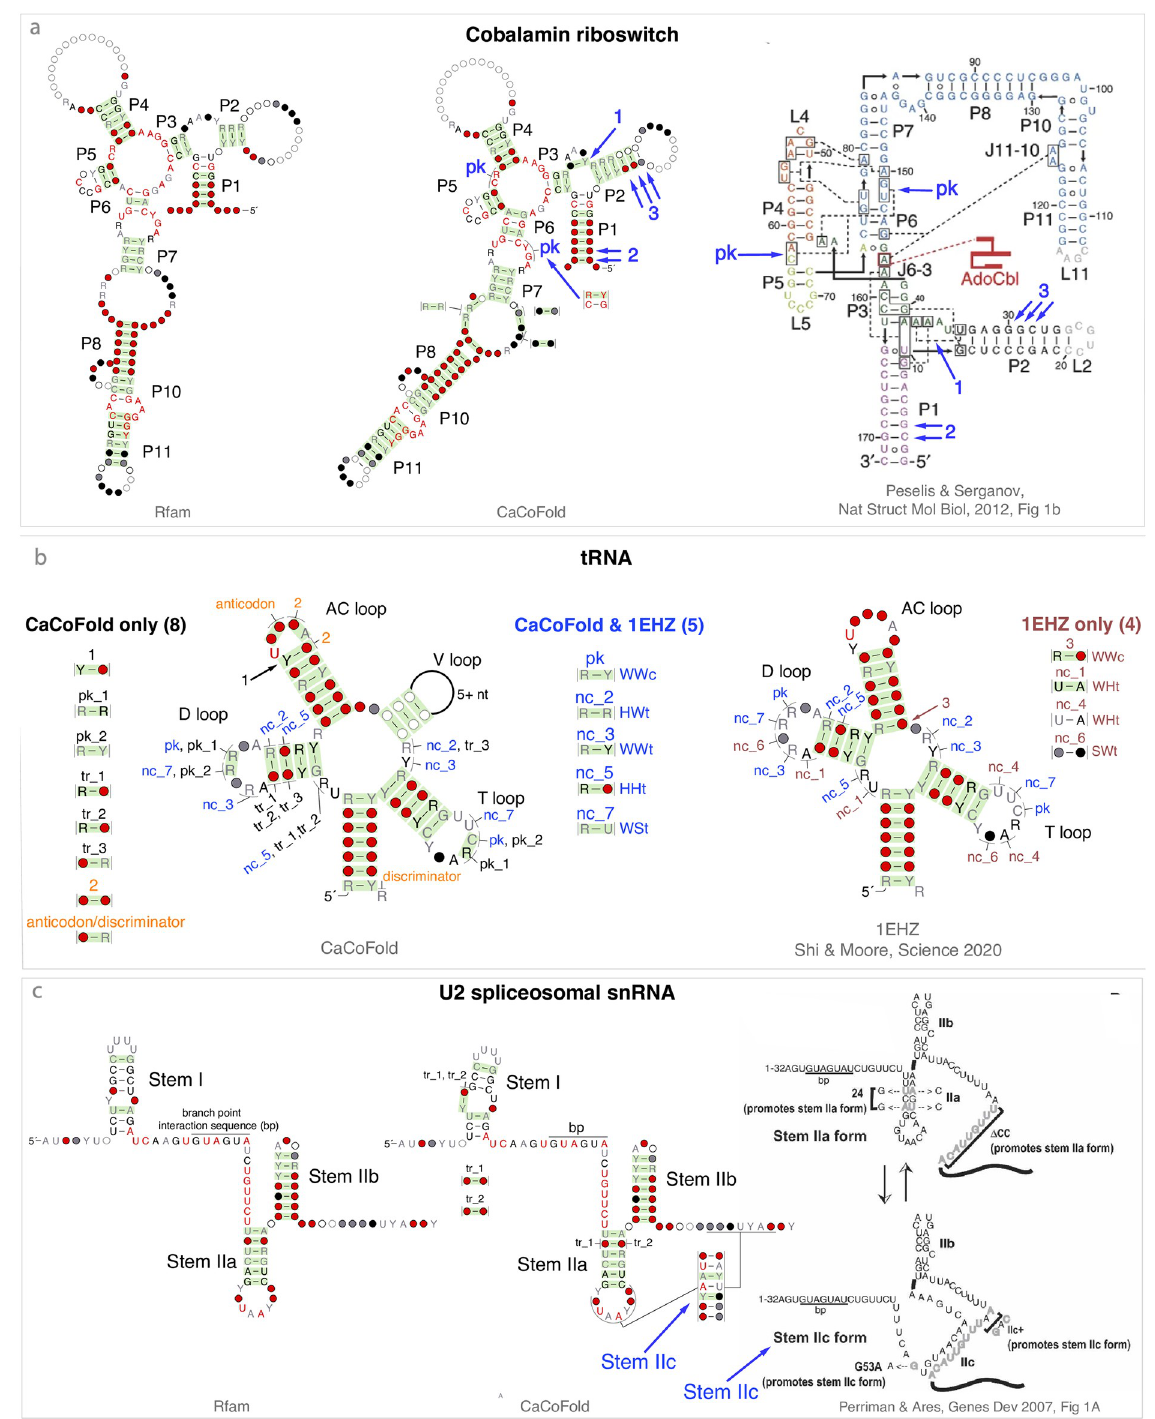
Fig 5. CaCoFold structures confirmed by known 3D structures (part 2/7). Structural elements with covariation support introduced by CaCoFold relative to the Rfam annotation and corroborated by 3D structures are annotated in blue. (a) Relative to the Rfam structure, the Cobalamin riboswitch CaCoFold structure adds one pseudoknot and one Watson-Crick basepair defining a four-way junction between helices P1, P2, and P3, both confirmed by the S. thermophilum crystal structure [49]. It also adds more covariation support for helices P1 and P2.